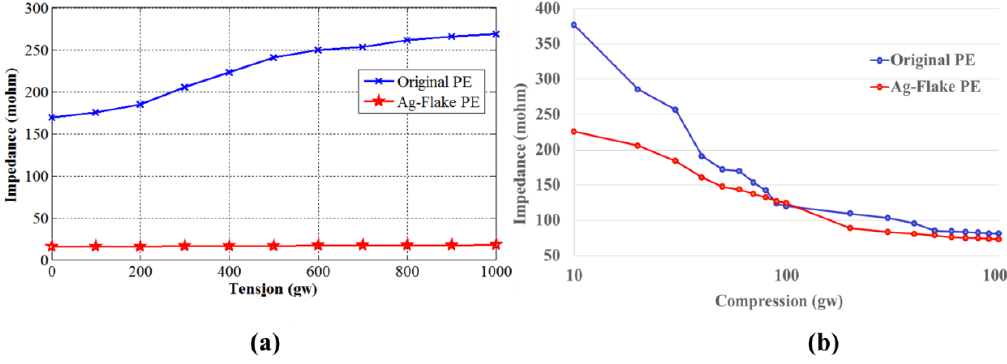
Figure 7. ( a ) Impedance tests of two PEs in different tensile stresses with a frequency of 40 Hz. ( b ) Top-bottom impedance tests of two PEs in different compressions with a frequency of 40 Hz.